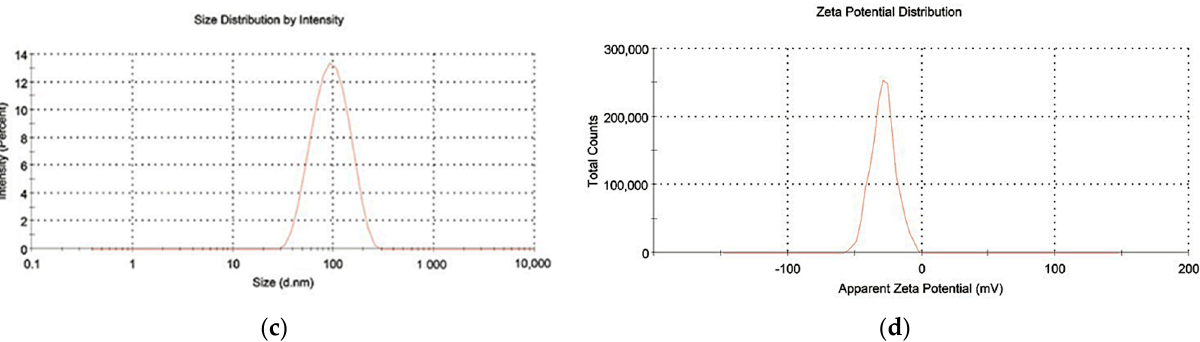
Figure 1. AgNPs biosynthesized by Fusarium oxysporum . ( a ) Fungal filtrate on the 1st day (left) and 15th day (right) after addition of silver nitrate (AgNO 3 ); ( b ) UV-Vis absorption spectrum of fungal filtrate after addition of AgNO 3 ; ( c ) AgNPs size distribution by intensity (Z-average 86.72 nm); and ( d ) Zeta potential distribution ( − 28.6 mV).